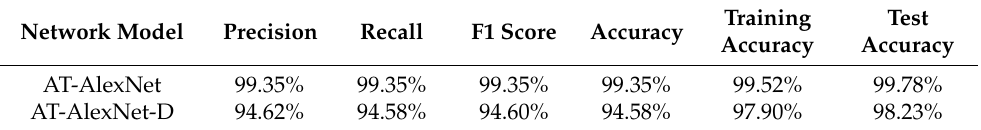
Table 8. A comparative test of AT-AlexNet and AT-AlexNet-D networks. Network Model Precision Recall F1